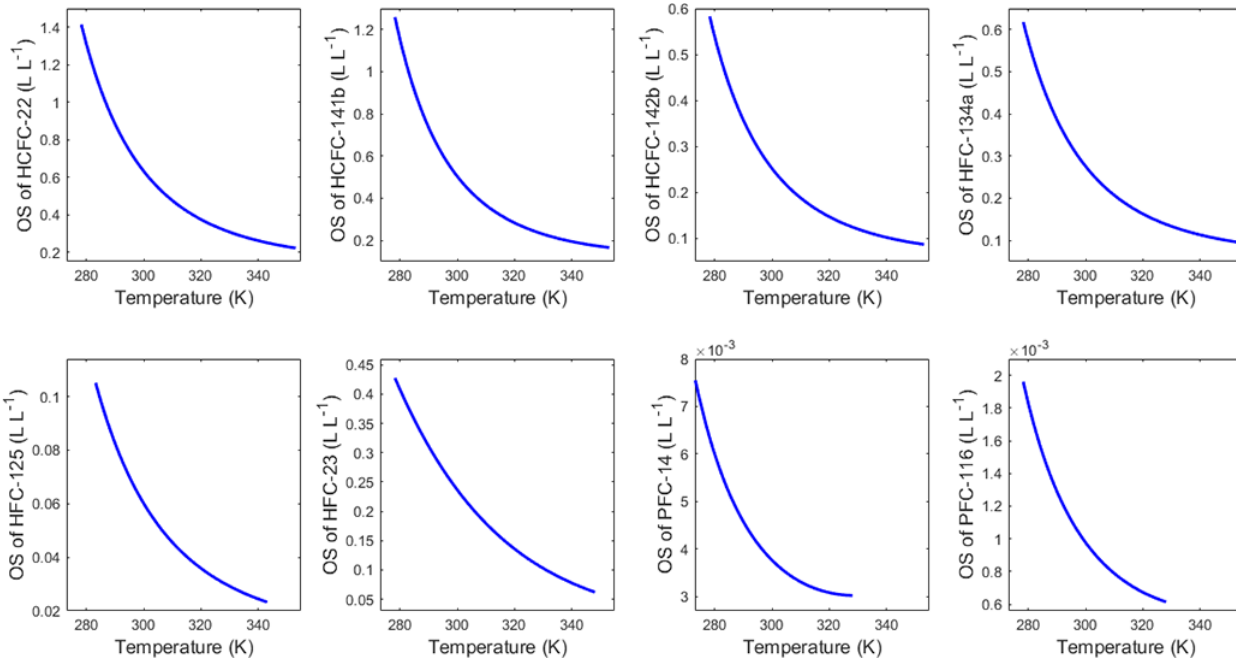
Figure 3. Temperature dependence of the Ostwald solubility (OS) coefficients in seawater for HCFC-22, HCFC-141b, HCFC-142b, HFC- 134a, HFC-125, HFC-23, PFC-14 and PFC-116 at a salinity of 35.